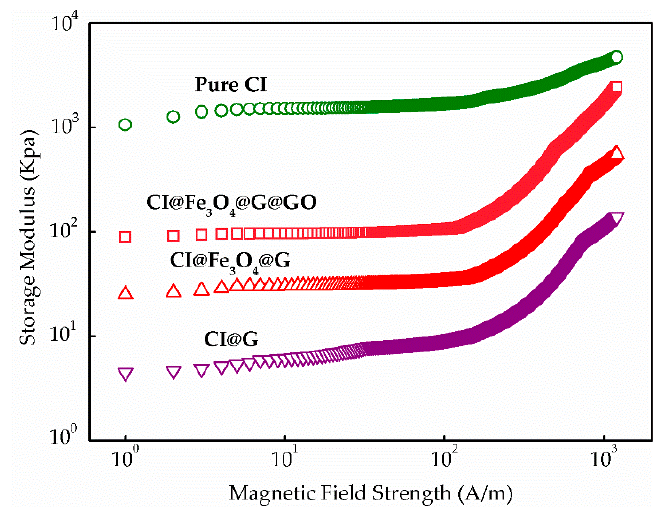
Figure 8. Magnetic field response properties for MR fluids based on pure CI, CI@G, CI@Fe 3 O 4 @G and CI@Fe 3 O 4 @G@GO particles.